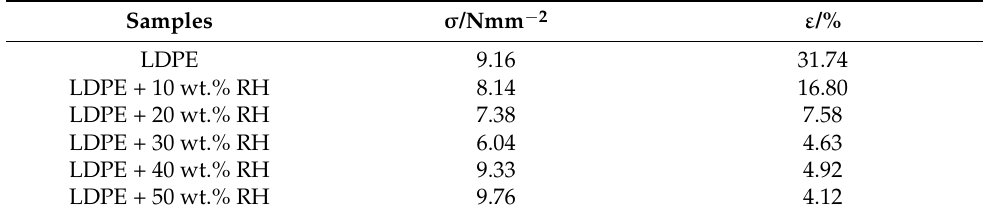
Table 7. Mechanical properties of the LDPE/RH